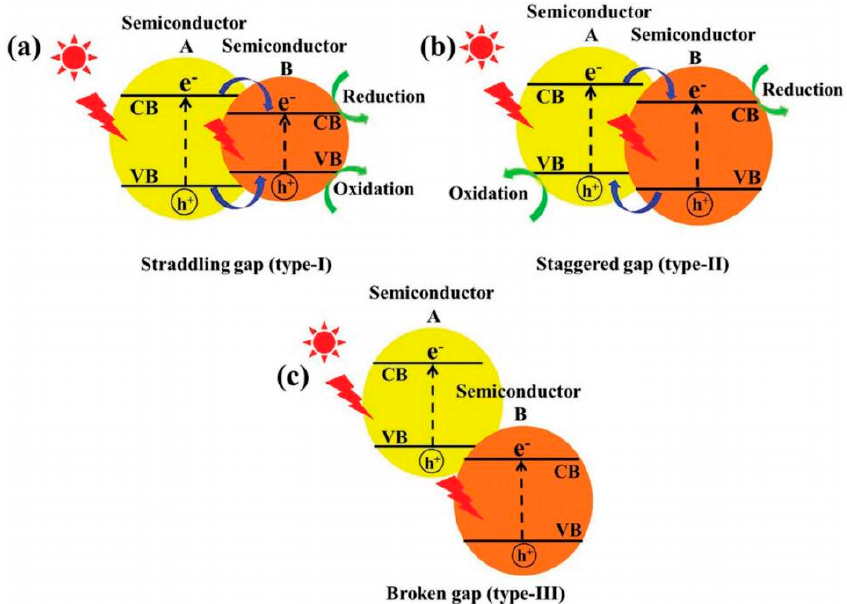
Figure 13. Schematic display of three kinds of electron–hole pair separation among composite photocatalysts: ( a ) type-I, ( b ) type-II, ( c ) type-III heterojunctions. Reproduced with permission from photocatalysts: ( a ) type- Ⅰ , ( b ) type- Ⅱ , ( c ) type- Ⅲ heterojunctions. Reproduced with permission Reference [105]; copyright (2017), John Wiley & Sons, from Reference [105]; copyright (2017), John Wiley & Sons, Inc.